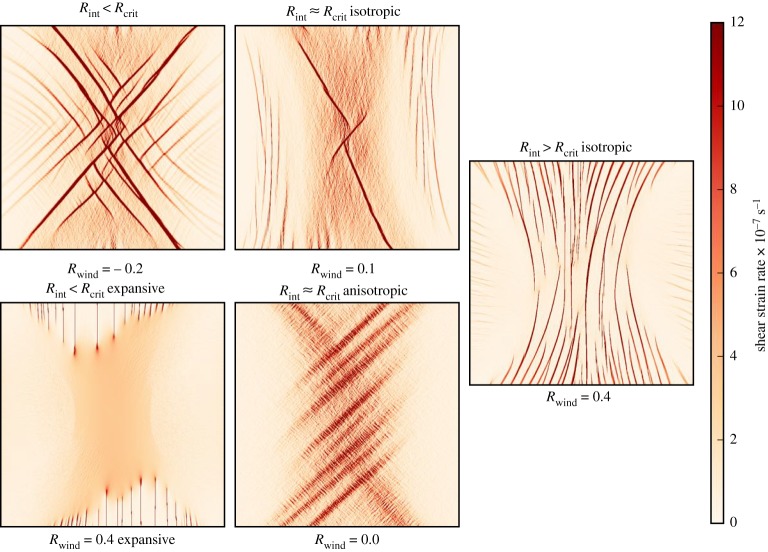
The five distinctive failure modes of sea ice. The shear strain rate after 6 h of model run showing the characteristic deformation of sea ice with internal stress confinement Rint about the critical confinement ratio Rcrit and for expansive wind stress. The confinement of wind stress Rwind used for each run is displayed below each figure.